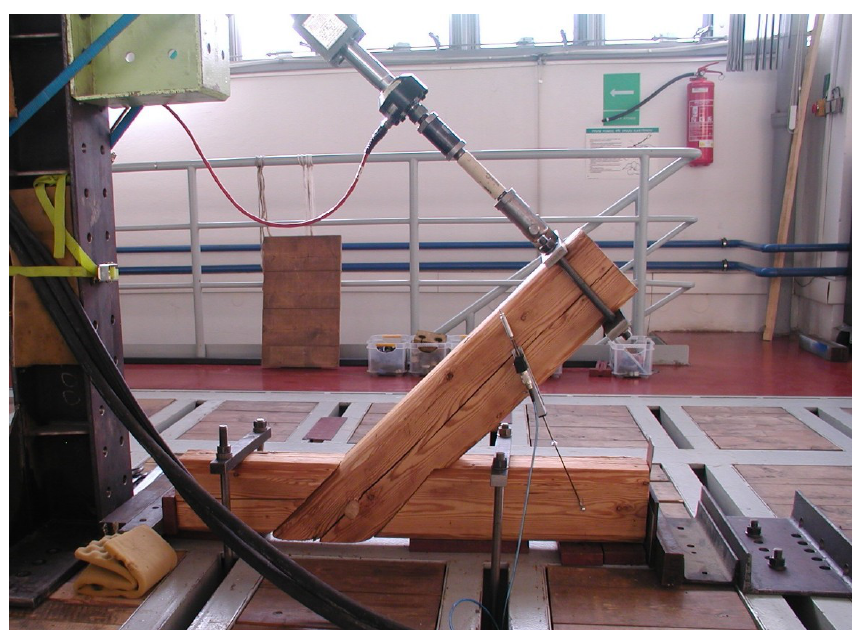
Figure 6. The test set-up.